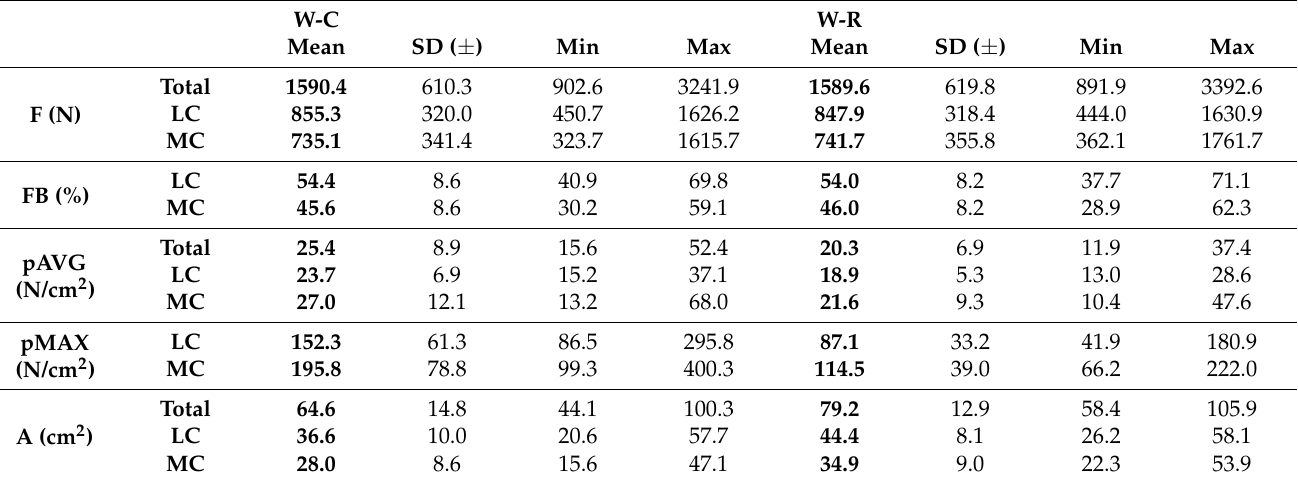
Table 2. Mean pressure data for ten dairy cows in total and differentiated between lateral claw (LC) and medial claw (MC) during walk on concrete (W-C) and rubber mats and medial claw (MC) during walk on concrete (W-C) and rubber mats (W-R).